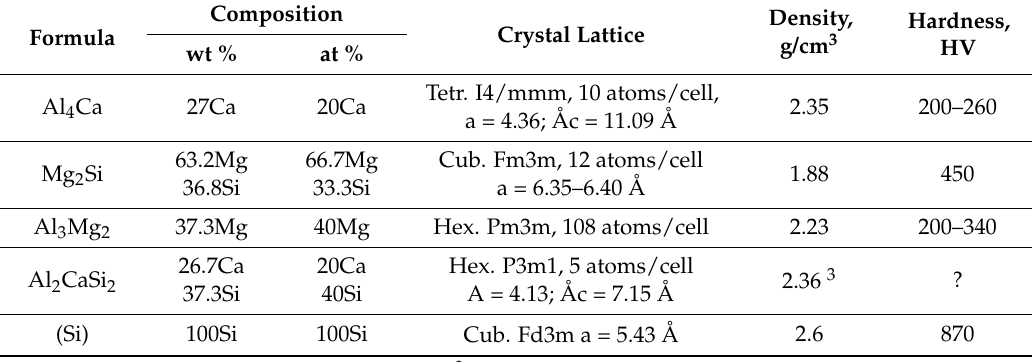
Table 2. Characteristics of phases in the Al-rich alloys of Al-Ca-Mg-Si system [2,4,32,35].